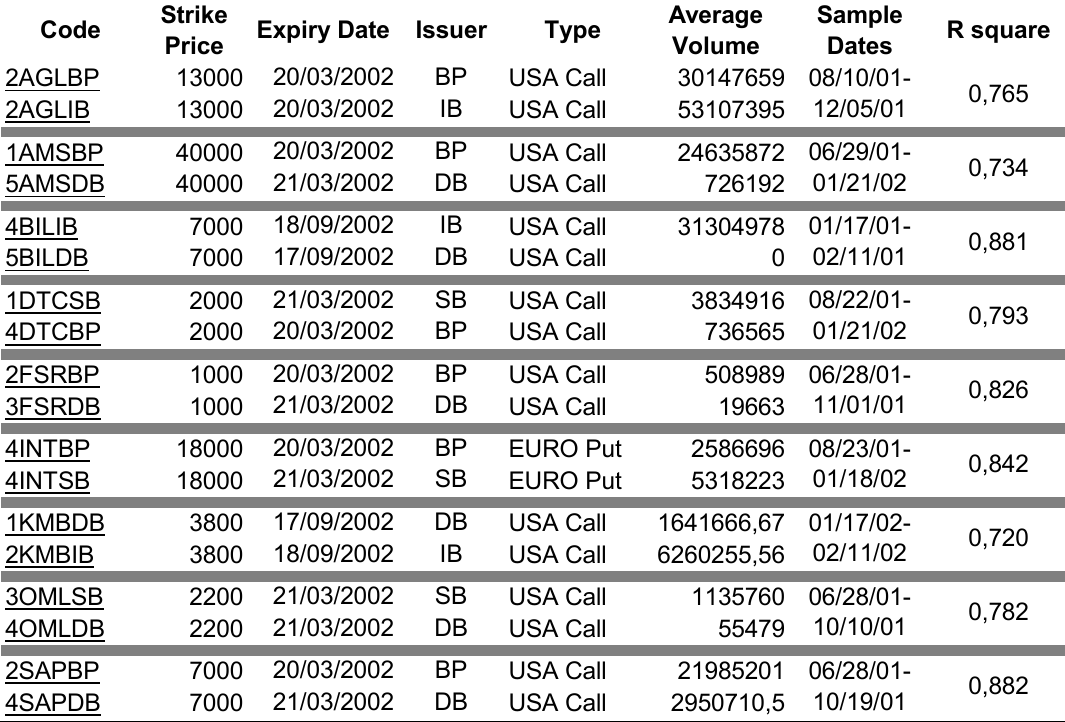
Table 2: Correlation between discrepancies in return on investment and differences in implied volatility for nine similar warrant